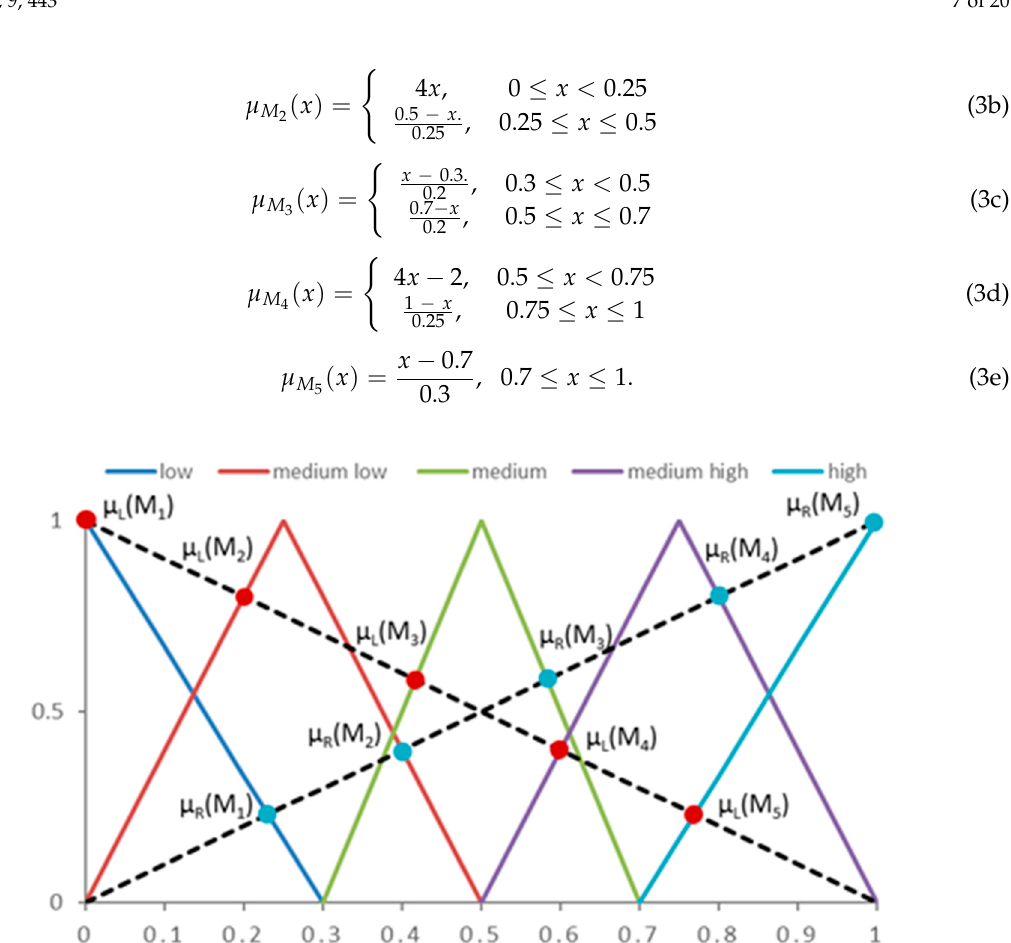
Figure 2. Illustration of determining crisp value.